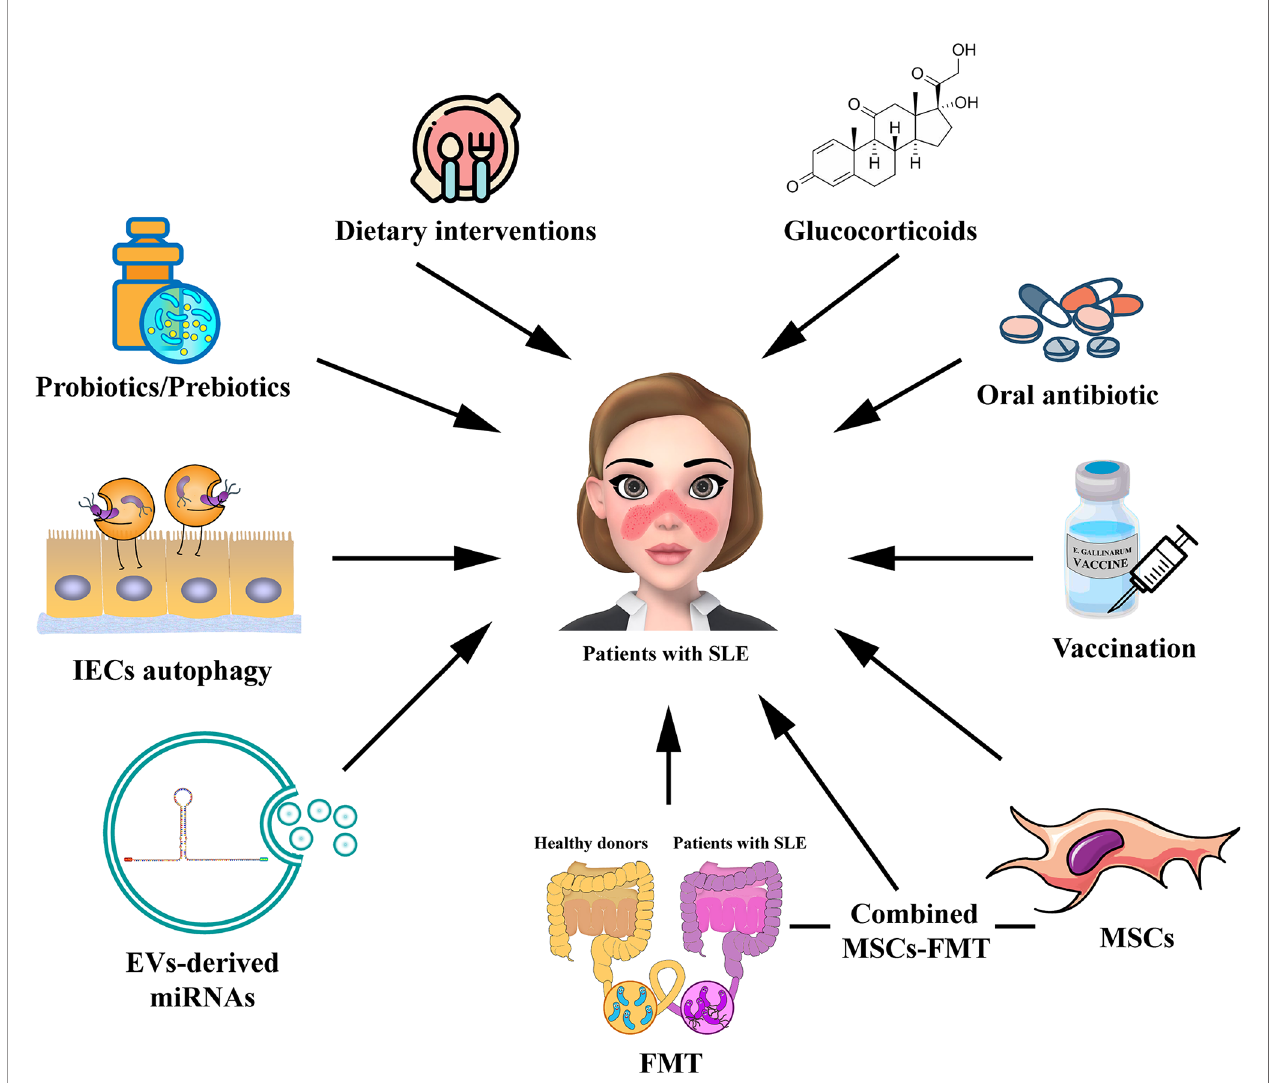
FIGURE 2 | Potential strategies for targeting gut microbiota in the treatment of patients with SLE. The potential therapies for modulating gut microbiota for SLE, including probiotic or prebiotic therapy, dietary interventions, oral antibiotic therapy, GC therapy, vaccination, FMT, regulation of IECs autophagy, EV-derived miRNA therapy, and MSC therapy. The combined MSC-FMT transplantation approach may have a better therapeutic effect for SLE. EV, extracellular vesicle; GC, glucocorticoid; FMT, Fecal microbiota transplantation; MSCs, mesenchymal stem